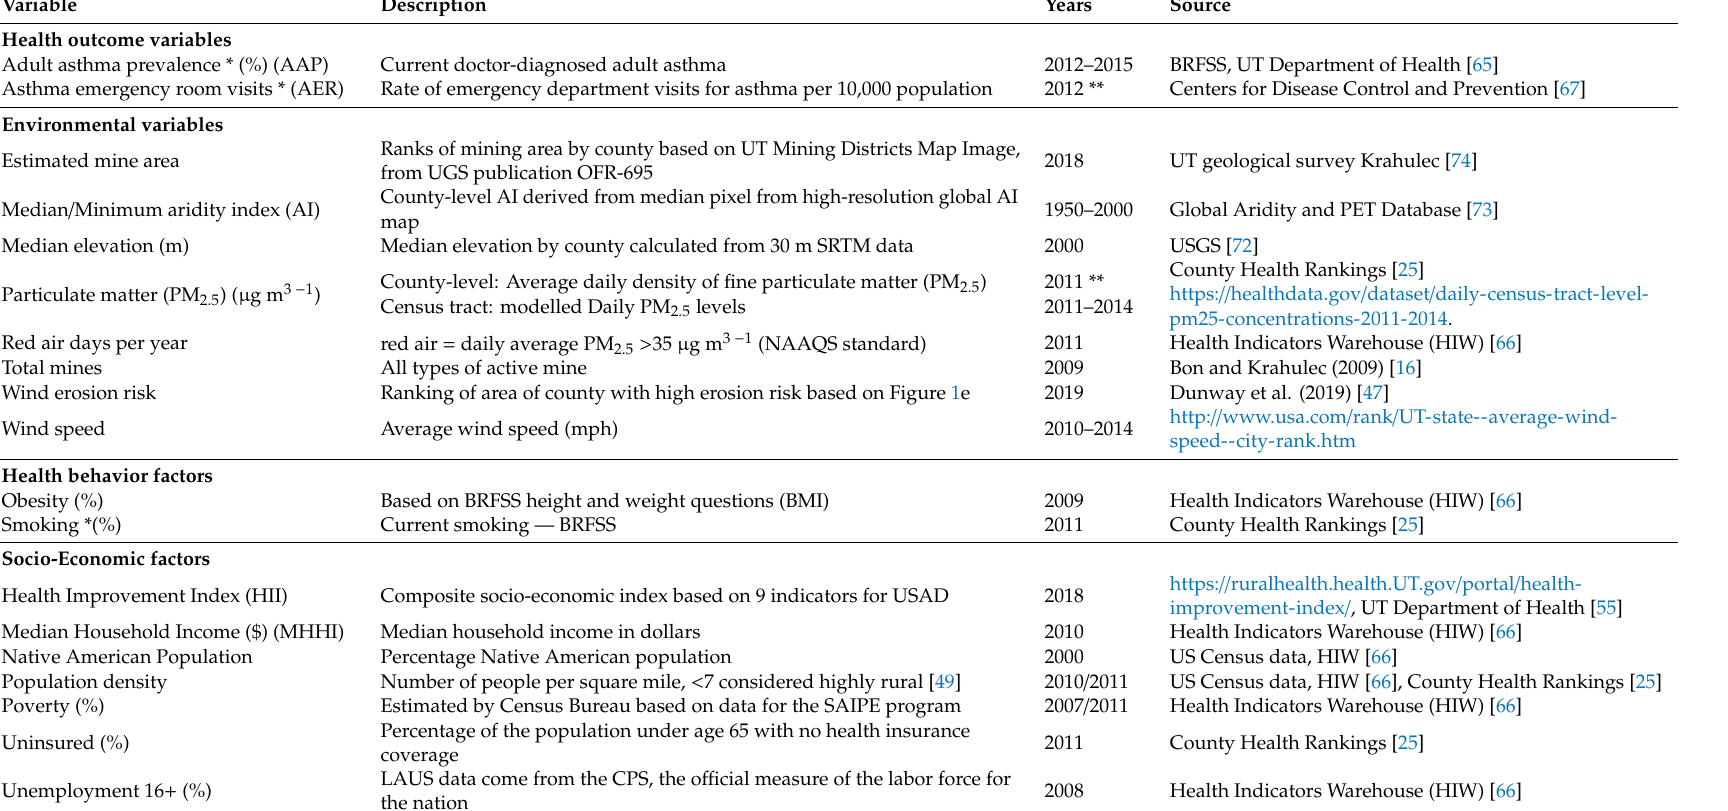
Table 1. Variable descriptions, dates and sources. All data is county-level unless otherwise